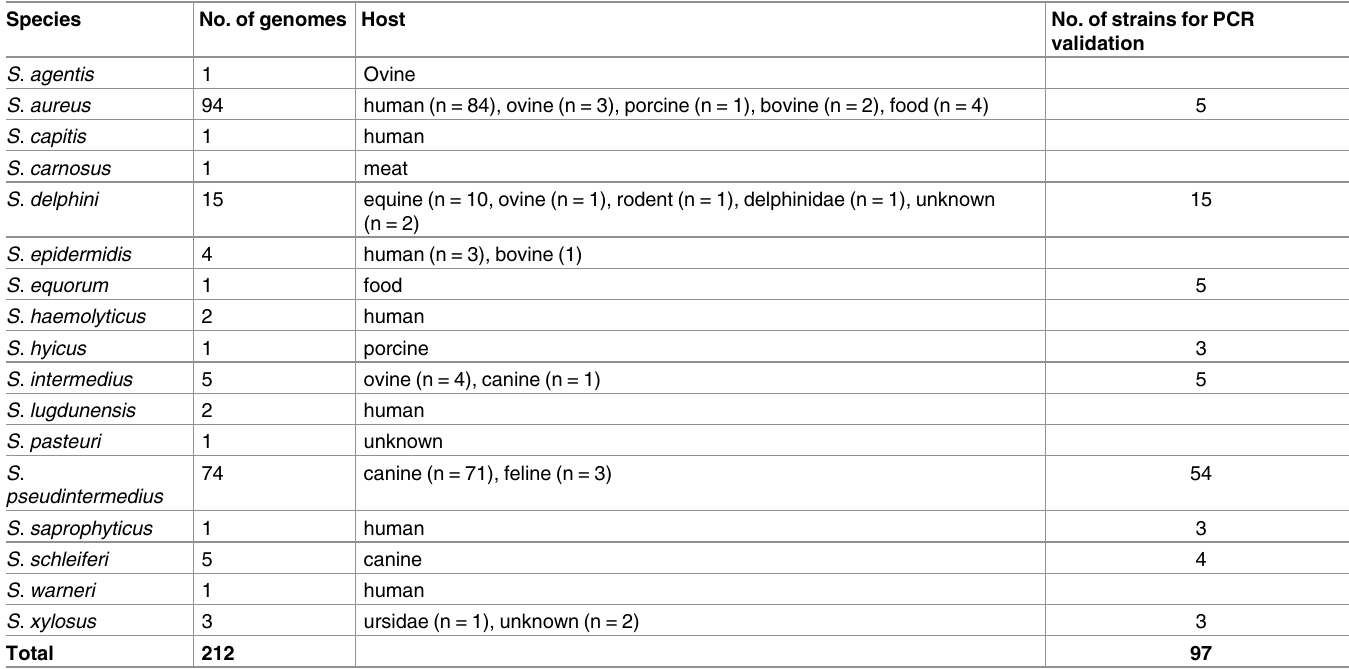
Table 1. Number of staphylococcal genome sequences used for sliding-frame analysis and strains for PCR validation.